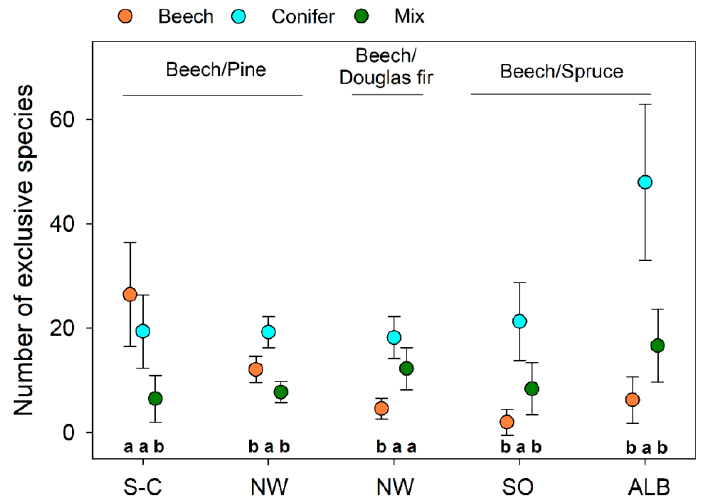
Figure 4. Mean number of exclusive species in pure beech, pure conifer and mixed stands of the four study regions based on pairwise comparisons of 1000 resamplings of 17 plots per stand type and region. Error bars indicate the 95% quantile of resamplings. Diagrams are arranged according to the considered tree species combination. Different lowercase letters indicate significant differences among stand types within regions (i.e., at least 975 of 1000 pairwise comparisons showed higher number of exclusive species of one stand type compared to the others), S-C: Schorfheide-Chorin, NW: Northwestern Germany, SO: Solling, ALB: Schwäbische Alb.